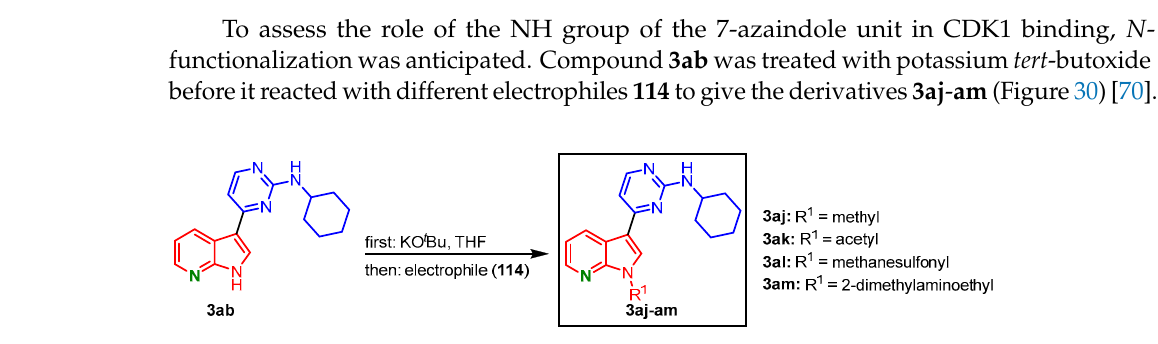
Figure 30. N -functionalization of compound 3ab with different electrophiles gave meriolins 3aj - am [70].